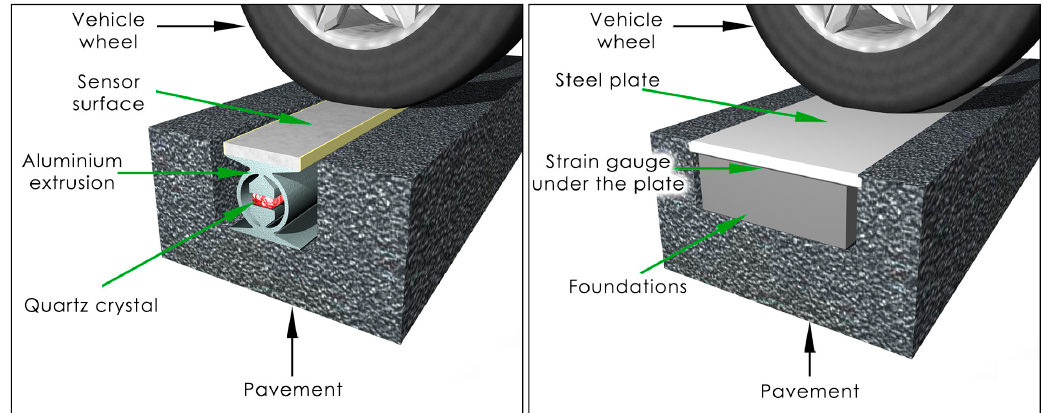
Figure 2. Quartz and bending plate sensors embedded in the pavement.